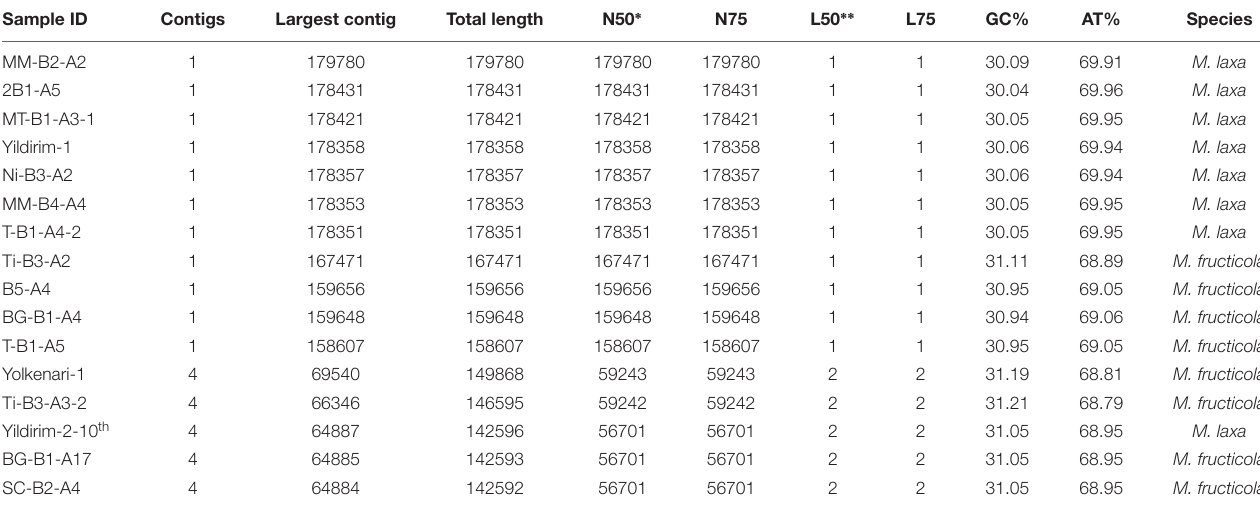
TABLE 2 | QUAST report for the 16 mitogenomes of Monilinia